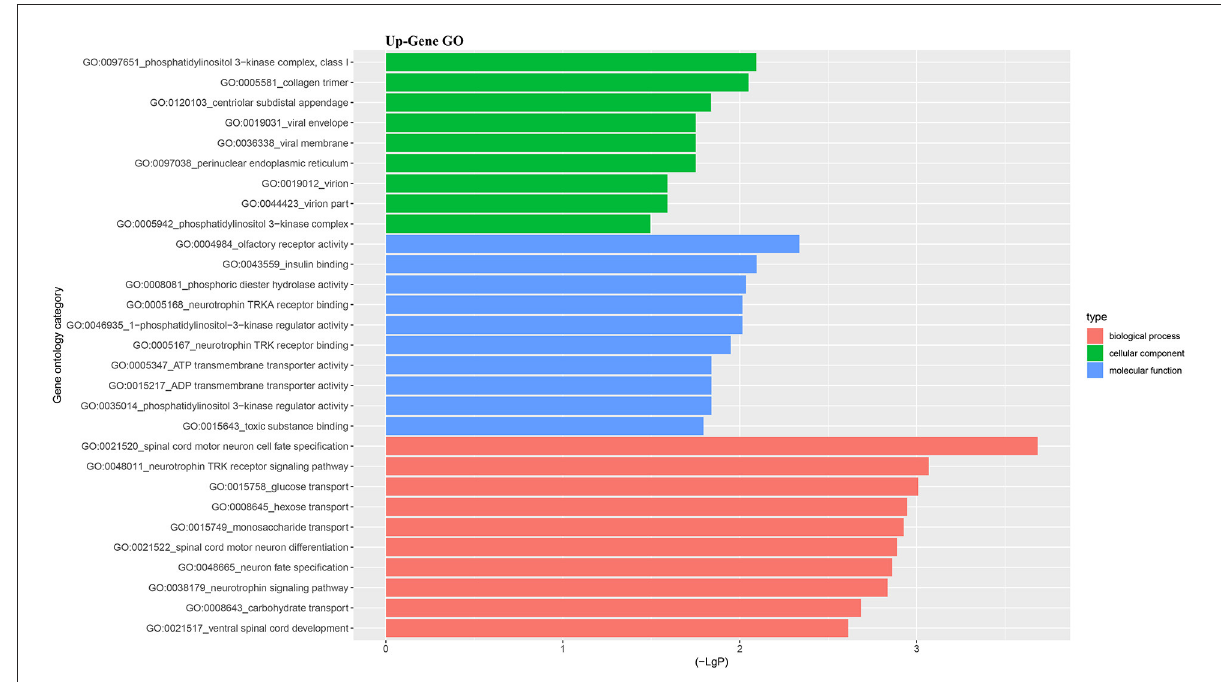
FIGURE3 Top 10 up-regulated GO terms of differentially expressed mRNAs which covering biological process, cellular component and molecular function, respectively.